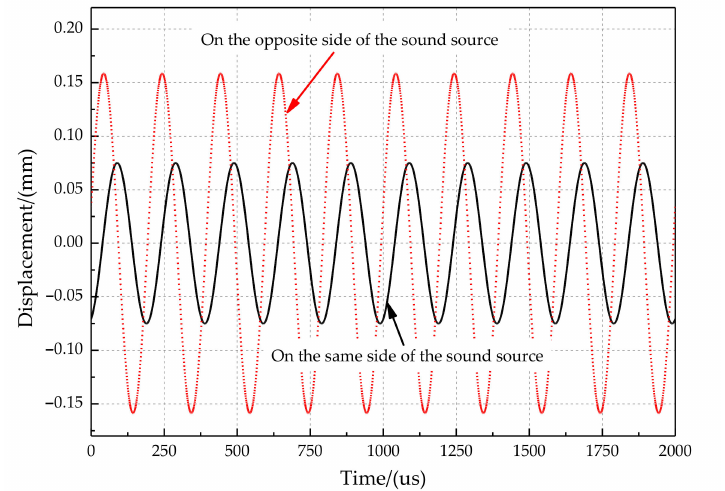
Figure 4. The time-domain response of two tympanic